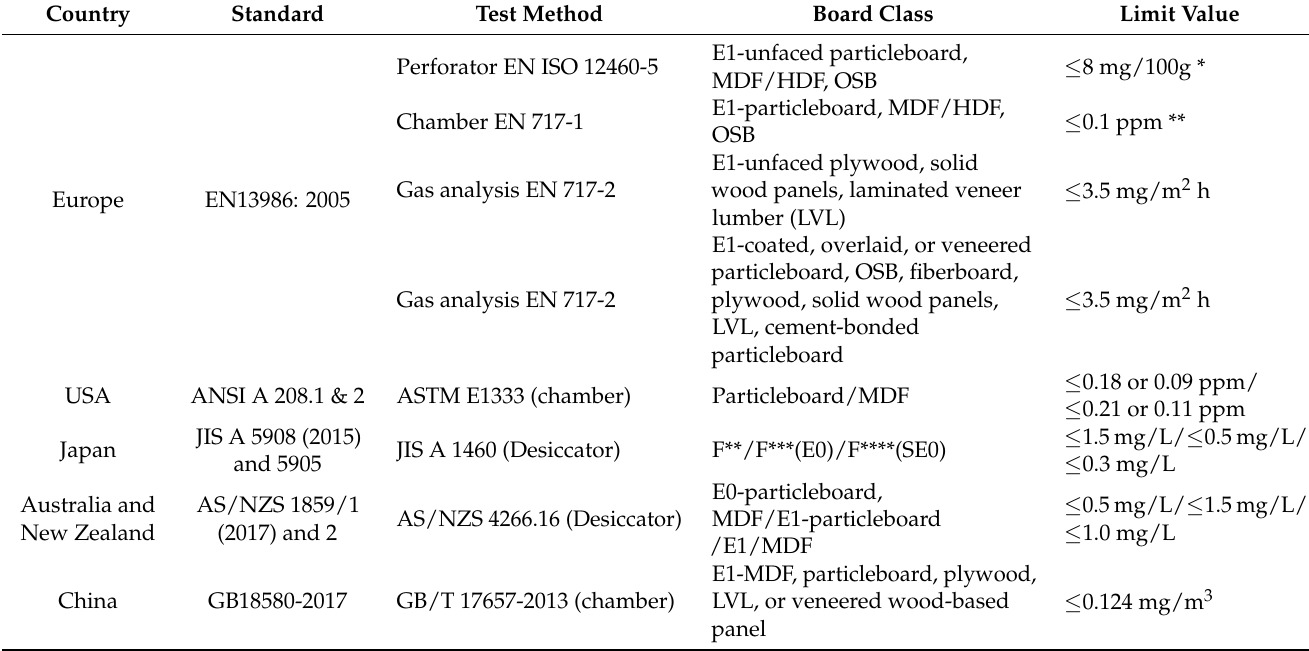
Table 1. Formaldehyde emissions standards for wood-based panels in Europe, USA, Japan, Australia, and